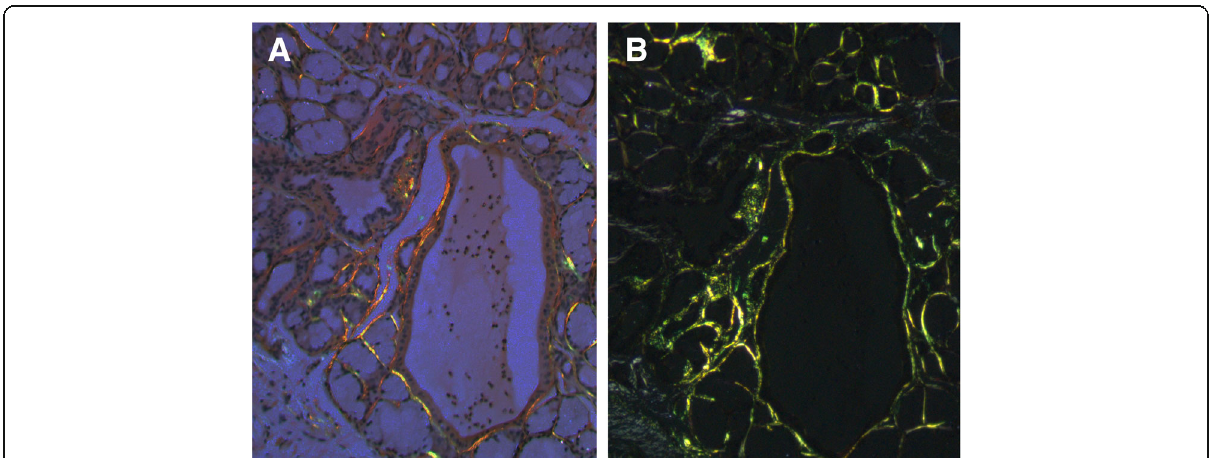
Fig. 1 Congo red stained salivary gland section examined under crossed polarized light from patient with AL amyloid imaged using clinical microscope (A) and same field examined using Metallurgical